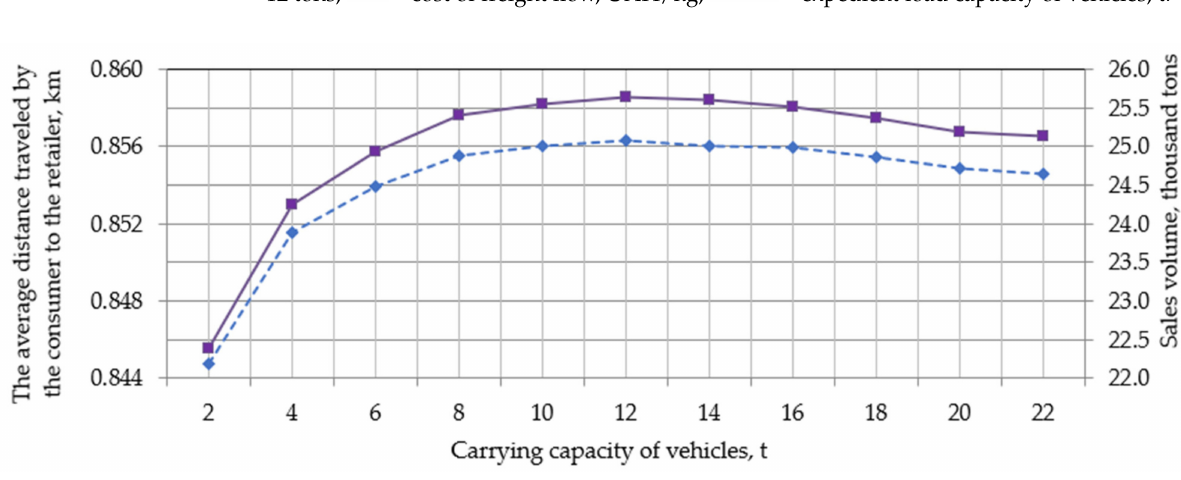
Figure 9. Patterns of changing the distance covered by the consumer to the retailer and the volume of sales according to the distribution scheme on the load capacity of vehicles: under the distribution scenario, thousand tons; the retail network,